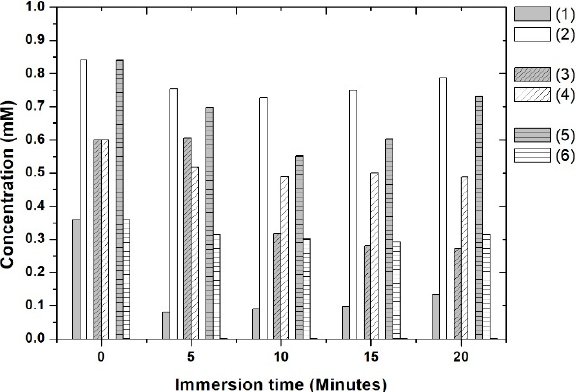
Figure 10. Concentrations of the binary solutions of β CP (1, 3, and 5) and CP–oxide (2, 4, and 6) from known concentrations in different ratios of 30/70, 50/50, and 70/30, respectively. Table 2. Extraction of β CP and CP–oxide from binary solutions of ratios 30/70, 50/50, and 70/30. Time Binary Solution